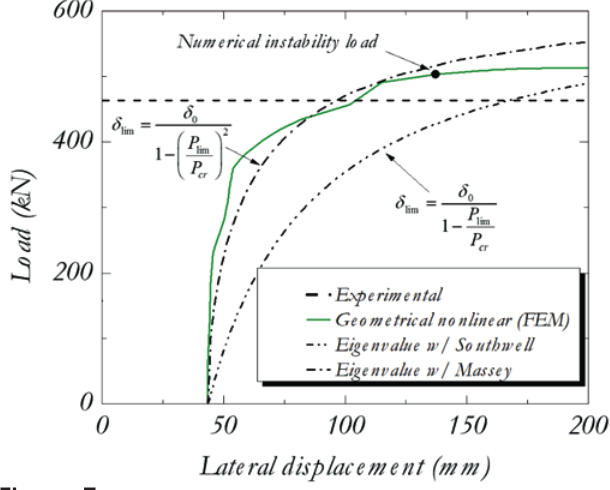
Figure 7 Numerical load-lateral displacement response and the experimental limit